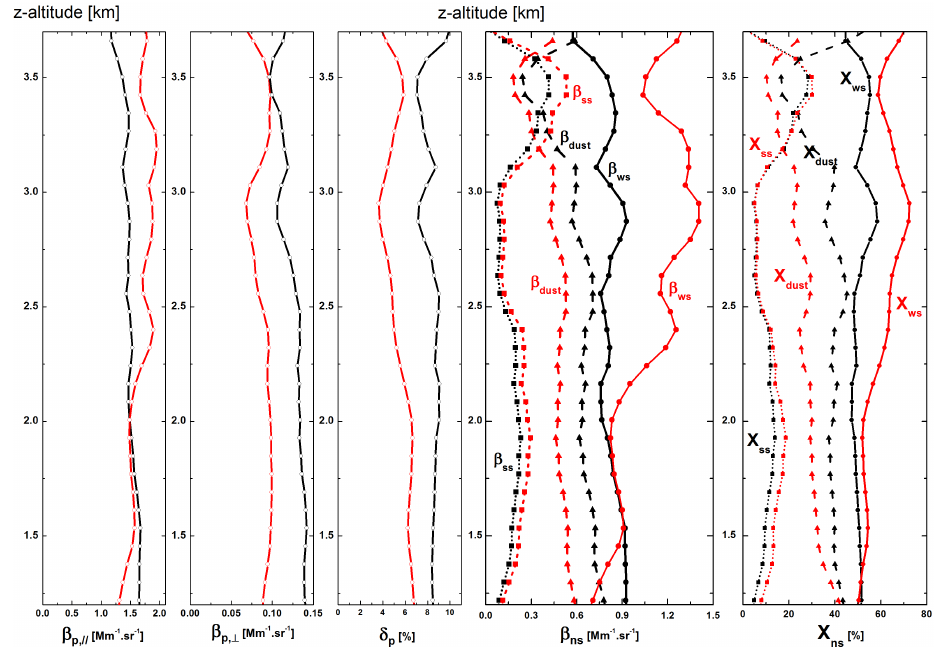
Fig. 10. Vertical profiles of β p ,// , β p , ⊥ , δ p , β dust (triangles), β ss (squares) and β ws (spheres) and fraction of ns-particles (dust, ss) and ws-particles (ws, spherical) in the three-component mixture on 18 October 2011 at 16:15 UTC at Lyon (France), addressed in the UV ( λ 1 =355nm, black) at and in the VIS ( λ 2 =532nm, red). To ease the reading, error bars are not plotted on this